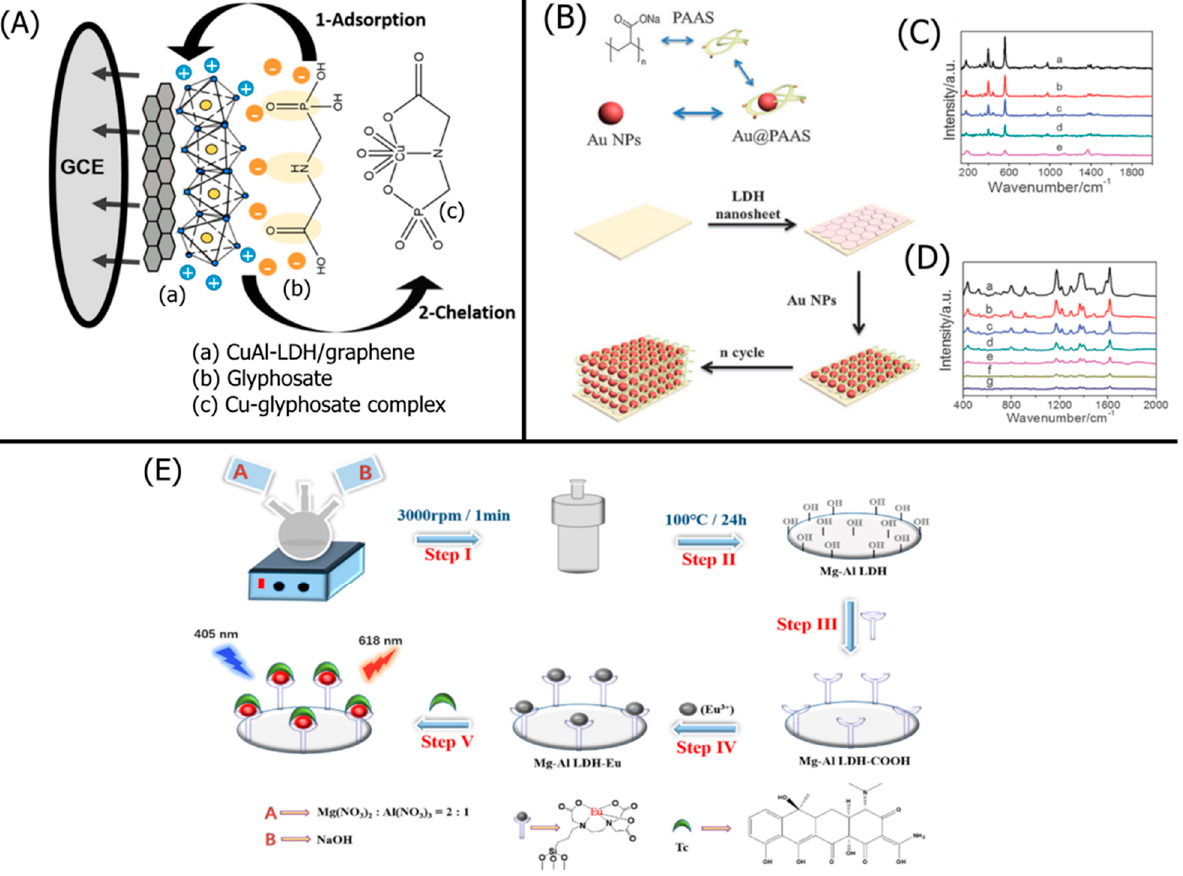
Figure 10. ( A ) Illustration of Cu oxidation suppression due to glyphosate adsorption followed by chelation, reproduced from reference [149] with permission from; MDPI, 2020; ( B ) schematic representation of the assembly of Au/PAAS/MgAl-LDH via a layer-by-layer assembly method. SERS detection toward ( C ) thiram (( a ) 10 − 3 M, ( b ) 10 − 4 M, ( c ) 10 − 5 M, ( d ) 10 − 6 M and ( e ) 10 − 7 M), and ( D ) malachite green (( a ) 10 − 6 M, ( b ) 10 − 7 M, ( c ) 10 − 8 M, ( d ) 10 − 9 M, ( e ) 10 − 10 M, ( f ) 10 − 11 M and ( g ) 10 − 12 M), reproduced from reference [150]. with permission from The Royal Society of Chemistry, 2015; ( E ) Schematic diagram of the synthesis and structure of the MgAl-LDH/Eu composite used for the colorimetric detection of tetracycline. Step I: Co- precipitation reaction among Mg(NO 3 ) 2 ·6H 2 O, Al(NO 3 ) 3 ·9H 2 O, and NaOH; Step II: Hydrothermal treatment for 24 h and MgAl-LDH was afforded; Step III: Silanization reaction with N-(trimethoxysilylpropyl) ethylenediamine triacetic (EDTA) acid sodium; Step IV: Encapsulation of europium ions and MgAl-LDH/Eu was obtained; and Step V: An “o ff− on” recog- nition process in the presence of tetracycline, reproduced from reference [53] with permission from American Chemical Society, 2019.